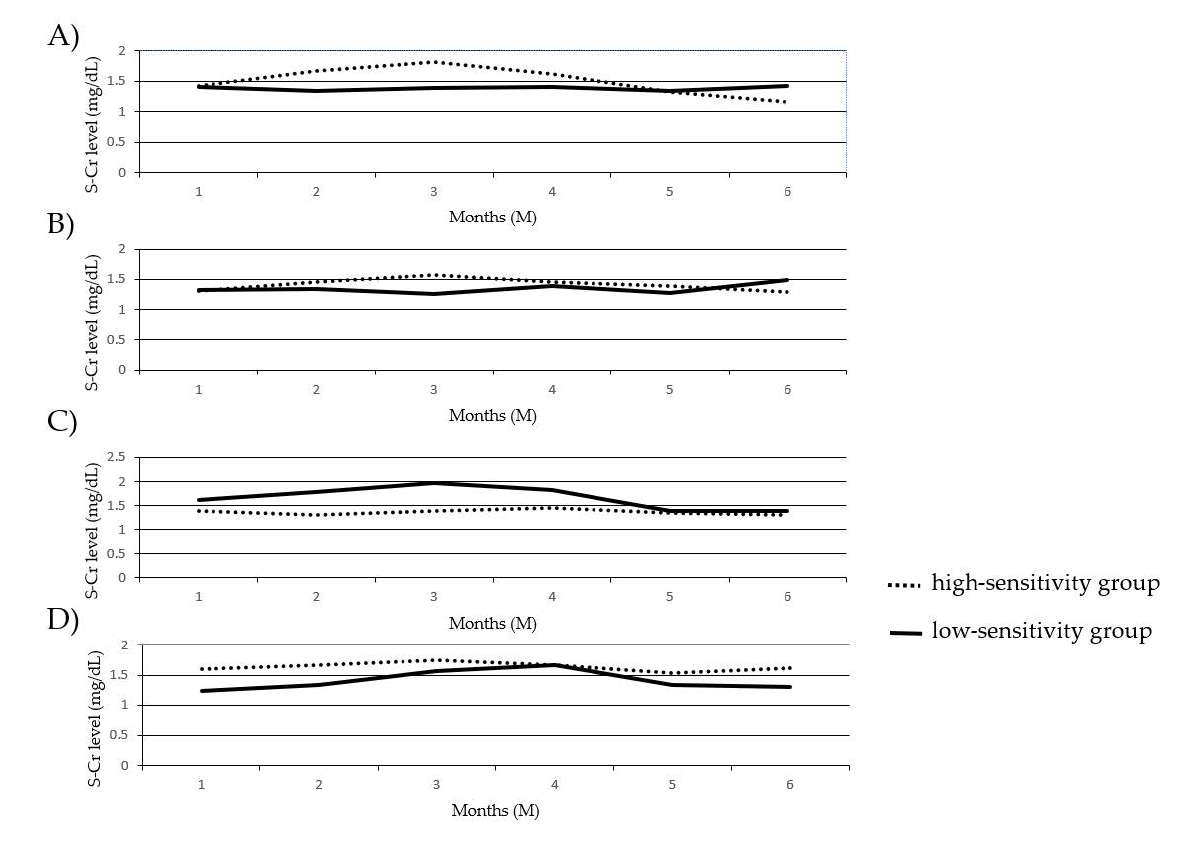
Figure 6. Comparison of the change in S–Cr levels between the PBMC high-sensitivity group and the PBMC low-sensitivity group to GCs. The changes in S–Cr levels in the PBMC high-sensitivity group and the PBMC low-sensitivity group to COR before transplantation ( A ), MPSL before transplantation ( B ), COR after transplantation ( C ), and MPSL after transplantation ( D ) were estimated. The solid lines and dashed lines indicate the data for the low-sensitivity and high- sensitivity groups,